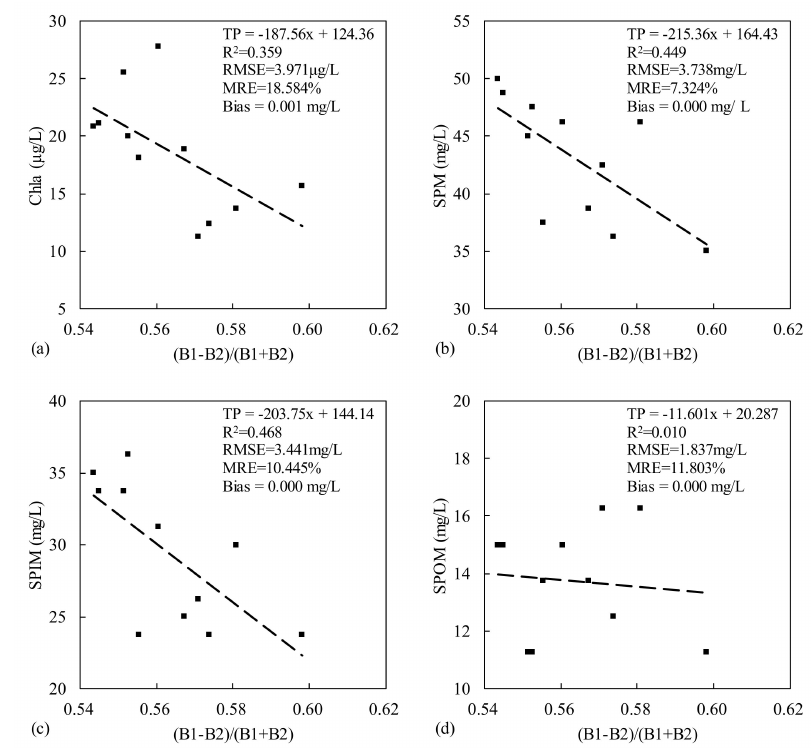
Figure 9. ( a ) Scatter plot of the (B1–B2) / (B1 + B2) and Chla concentration in Lake Nanyi; ( b ) scatter plot of the (B1–B2) / (B1 + B2) and SPM concentration in Lake Nanyi; ( c ) scatter plot of the (B1–B2) / (B1 + B2) and SPIM concentration in Lake Nanyi; ( d ) scatter plot of the (B1–B2) / (B1 + B2) and SPOM concentration in Lake